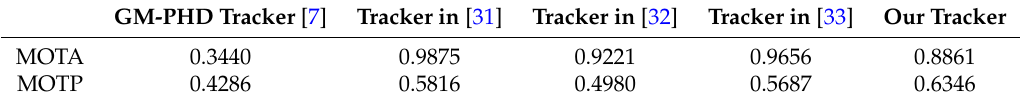
Table 3. Tracking performance comparison on the subway station surveillance scenario of PETS2006.